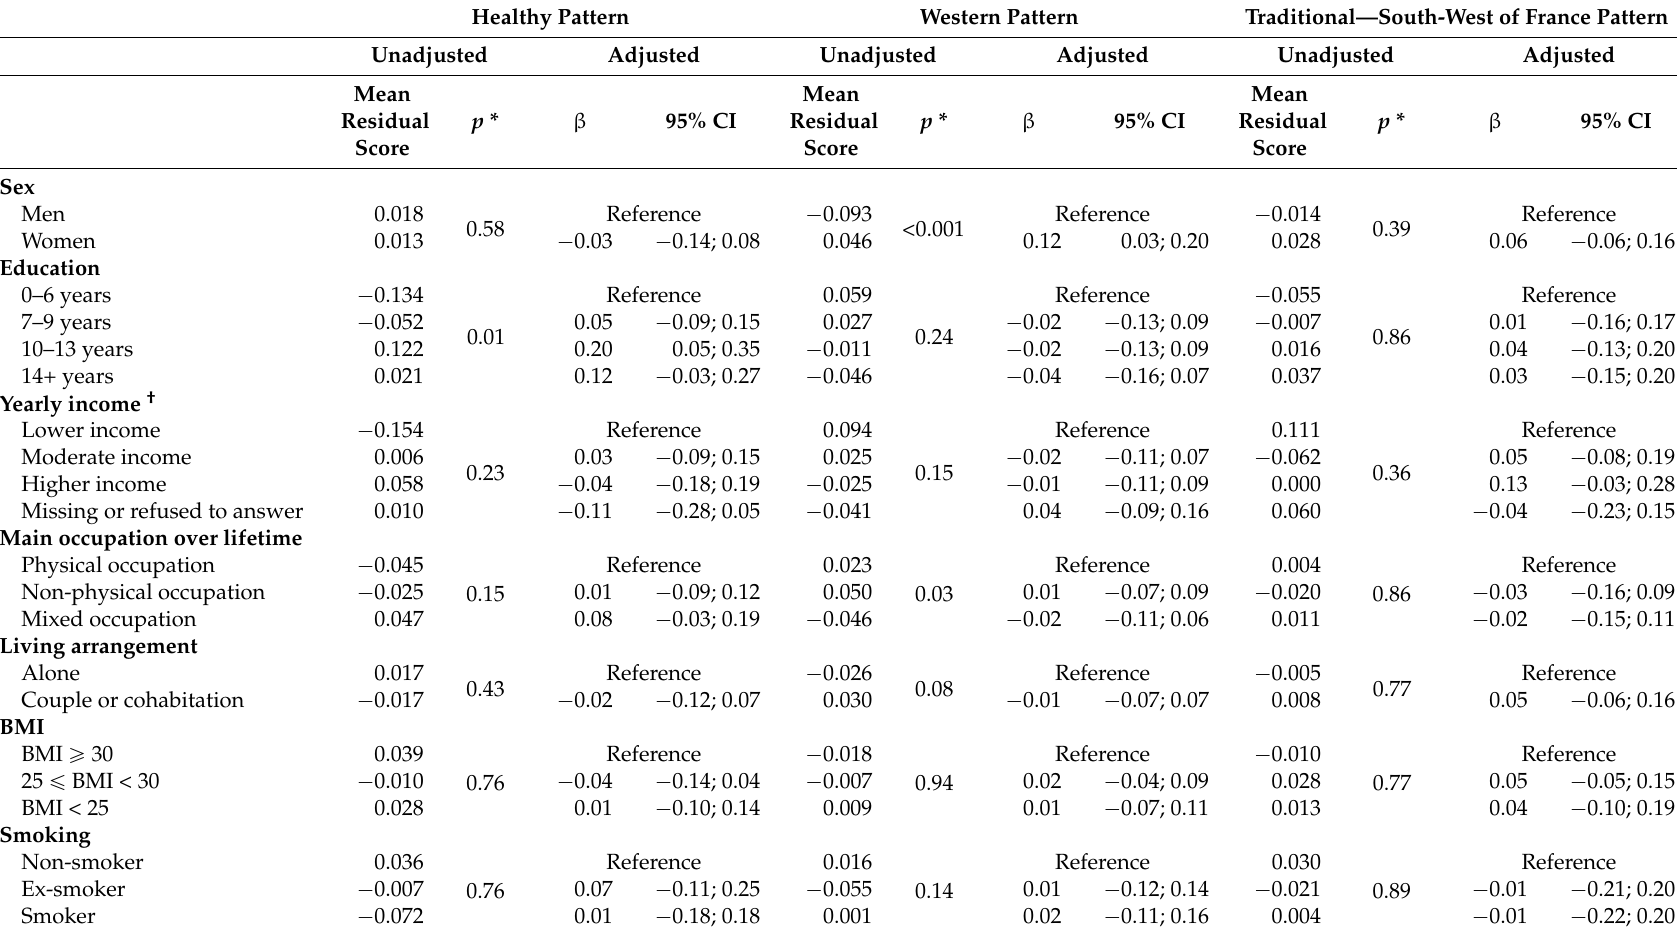
Table 5. Associations between social, health and lifestyle characteristics of the subjects and nutrient patterns in 3C ( n = 1712). Healthy Pattern Western Pattern Traditional—South-West of France